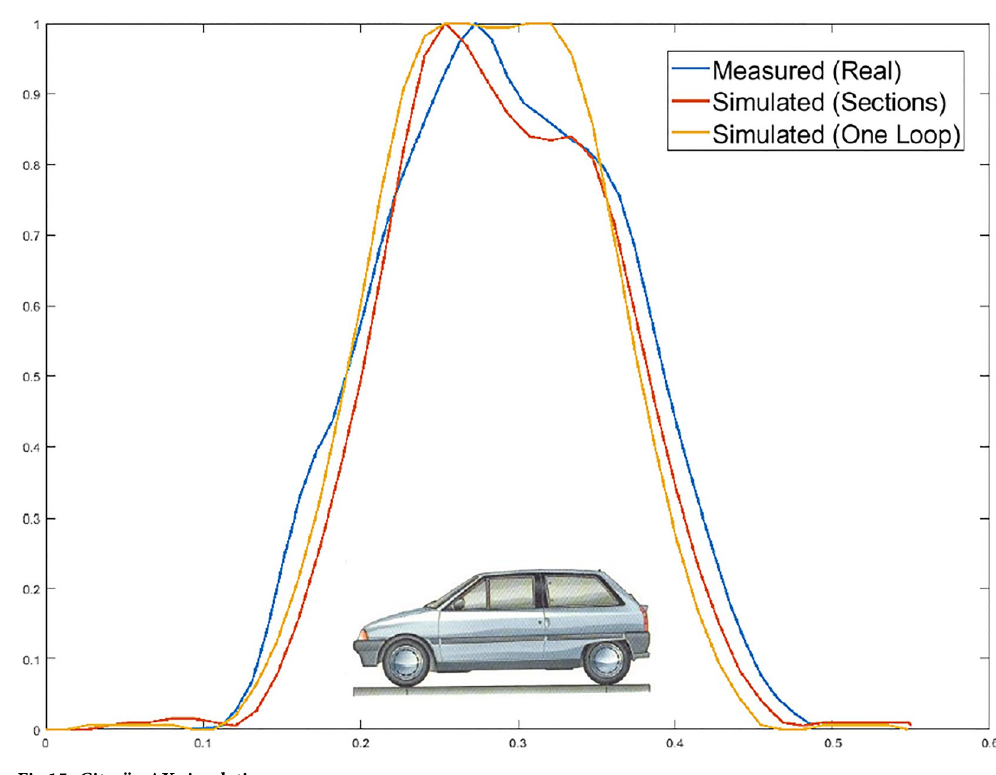
Fig 15. Citroe¨n AX simulation.